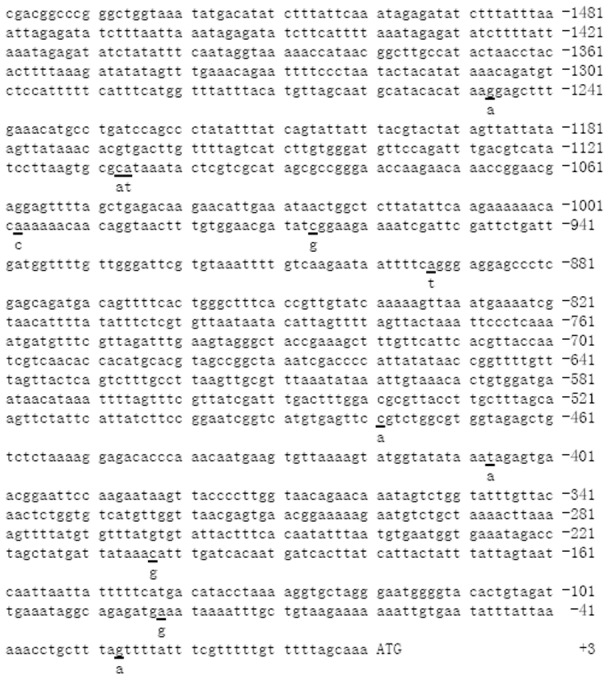
The polymorphisms in the promoter region of AiHSP70.The negative numbers indicate upstream sequence relative to the translation start codon and are numbered on the right. The polymorphism sites are underlined and the variants are described below.